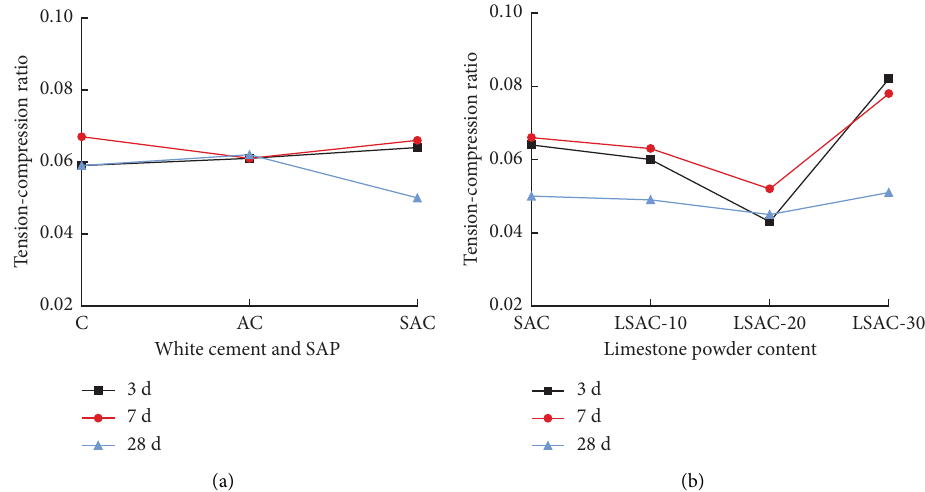
Figure 9: Tensile-compression ratio curves of diferent types of fair-faced concrete. (a) Efects of white cement and superabsorbent resin. (b) Efect of limestone powder content.